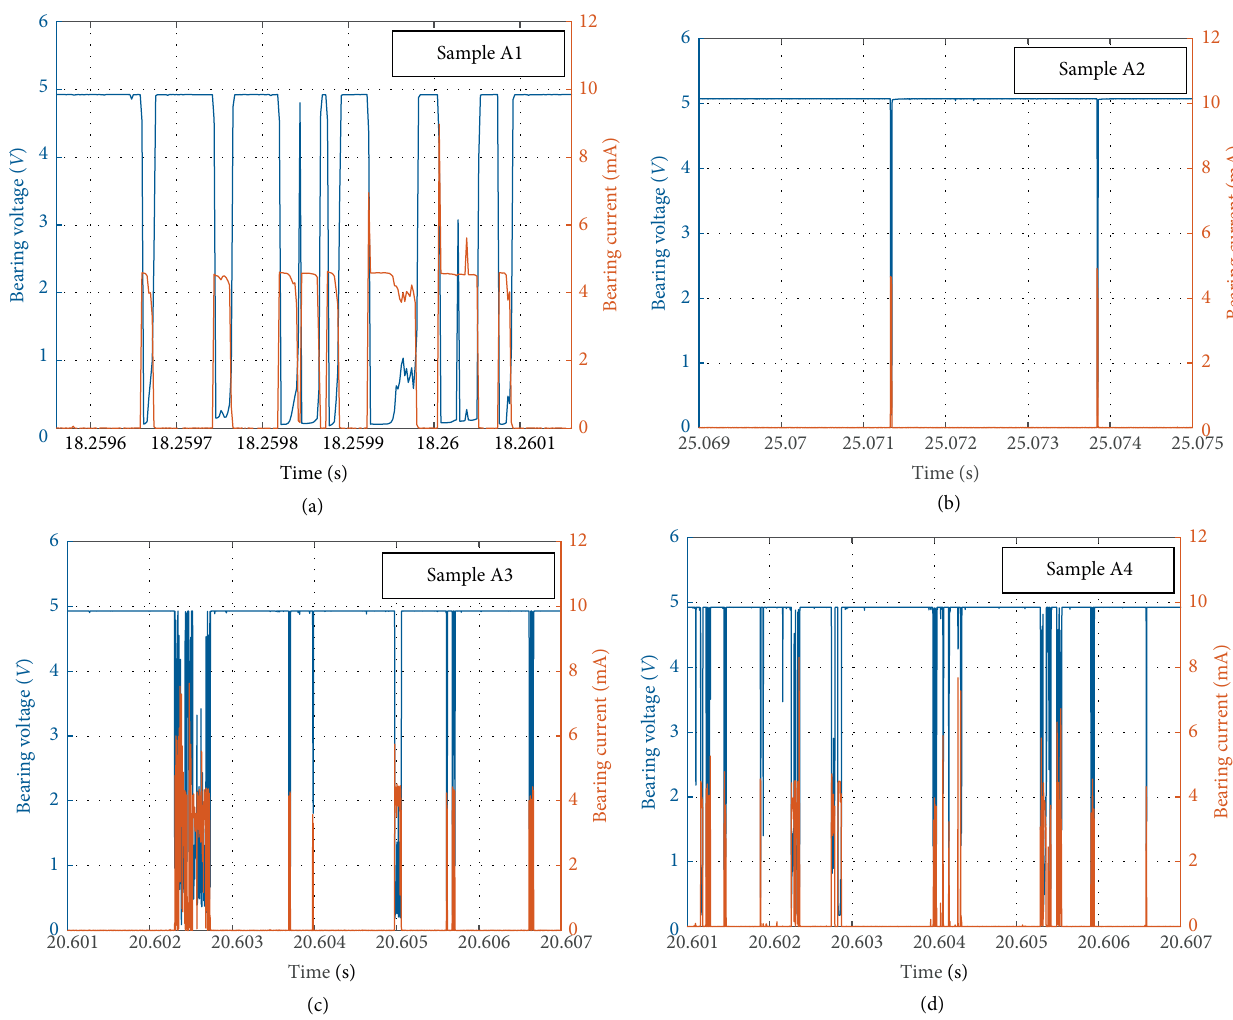
Figure 5: Bearing voltage (blue) and bearing activity (orange) for particle-initiated breakdowns due to different types of particles. The particle concentration is 150 mg/L and the measurement window shown is of 600 µ s for tests shown